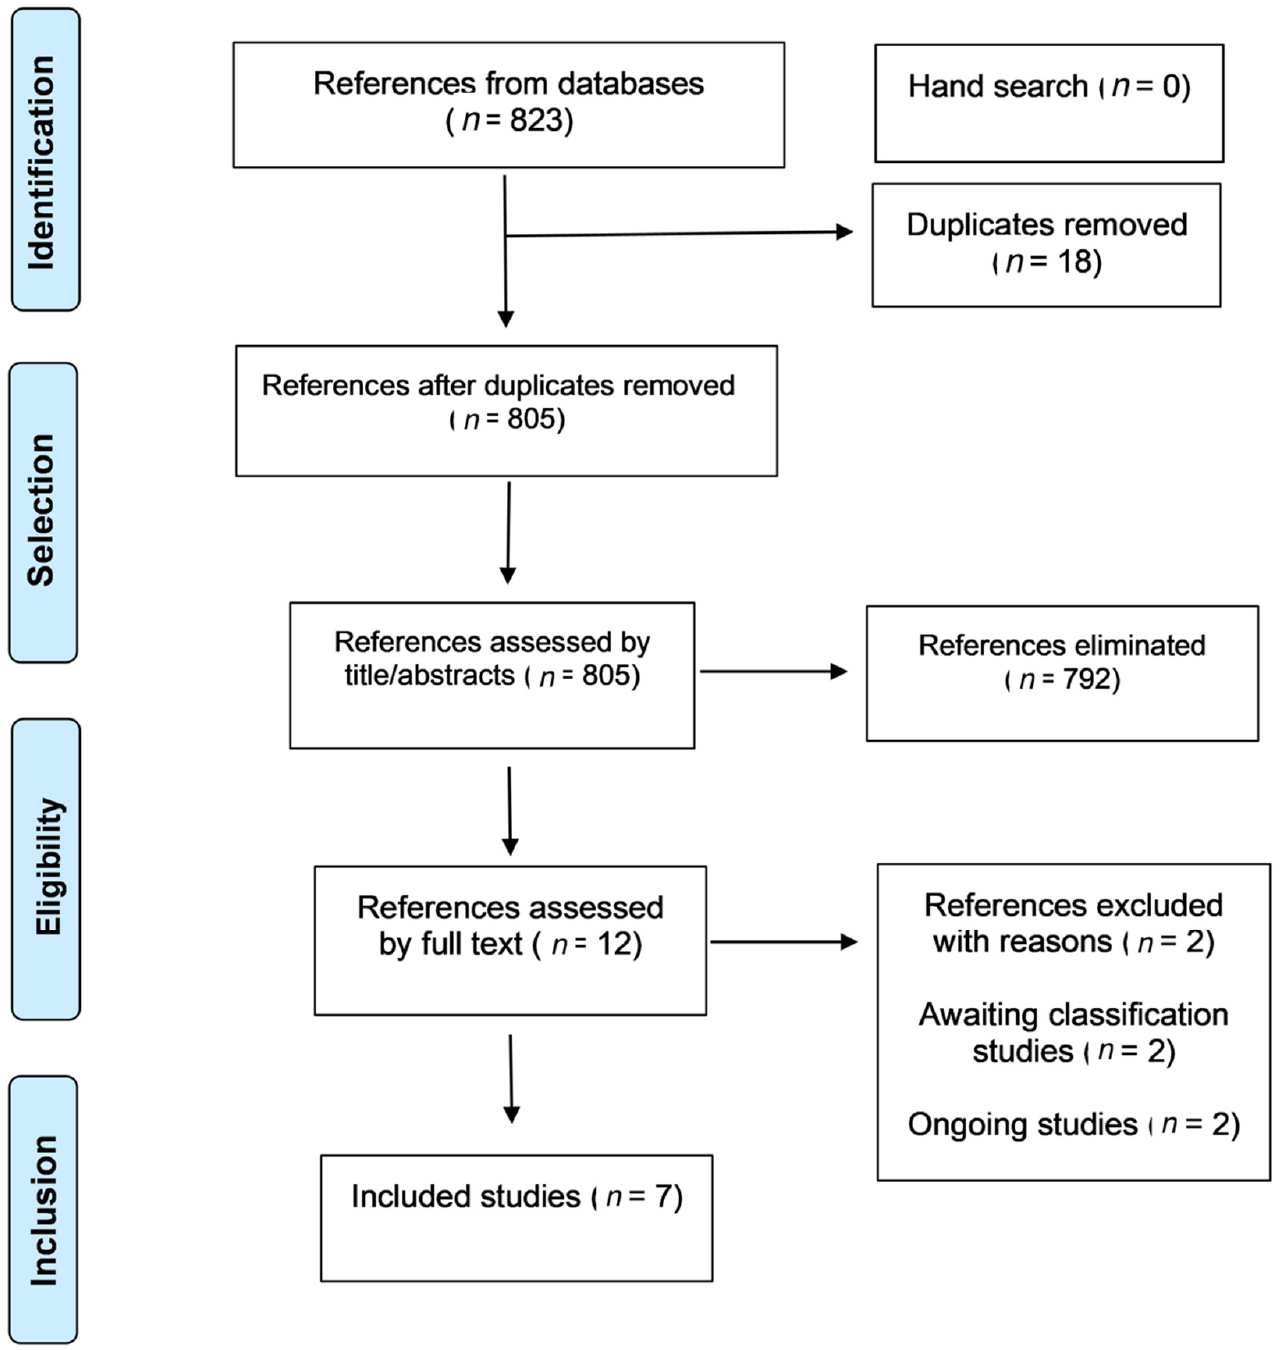
Figure 1. PRISMA flowchart of the study selection process. Included studies assessed the outcomes, evaluated between 3 days and 14 days after treatment. Only three RCTs [13,15,16] reported financial support sources. The included studies and their main characteristics are shown in Table